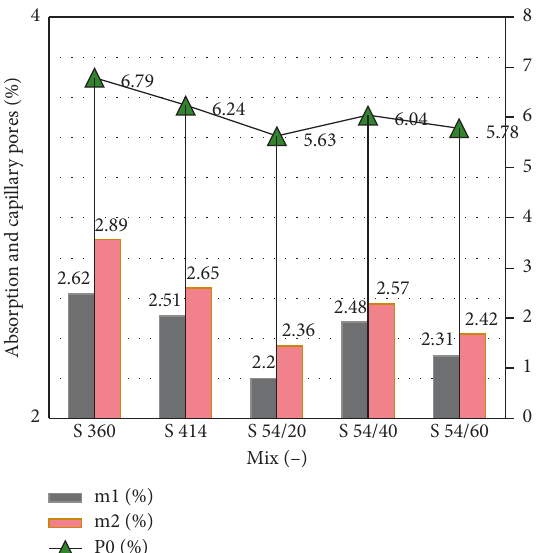
Figure 13: Water absorption and permeable pores’ content